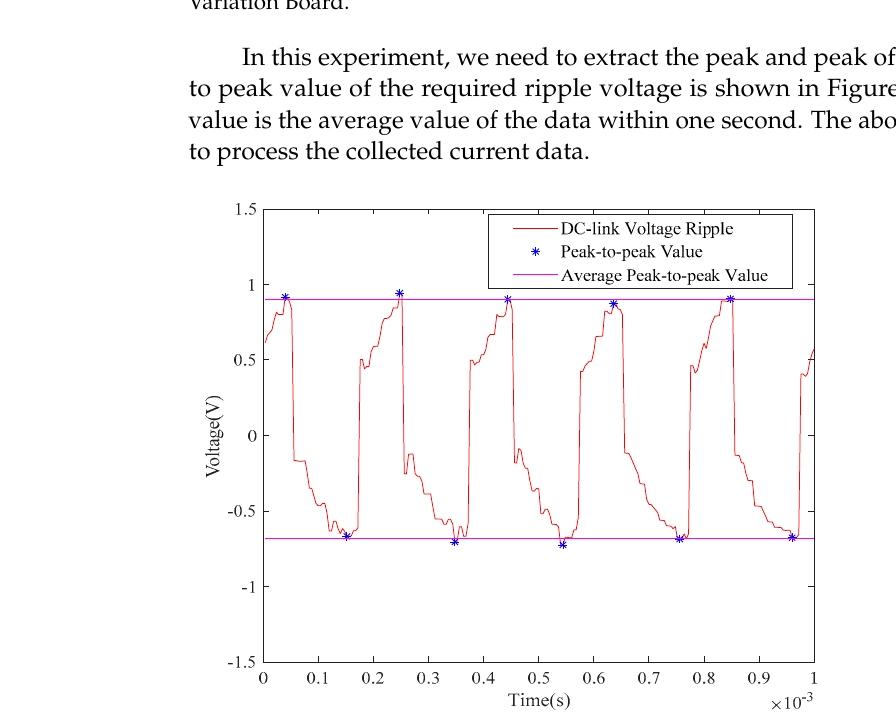
Figure 9. The peak-to-peak value of the required ripple voltage.